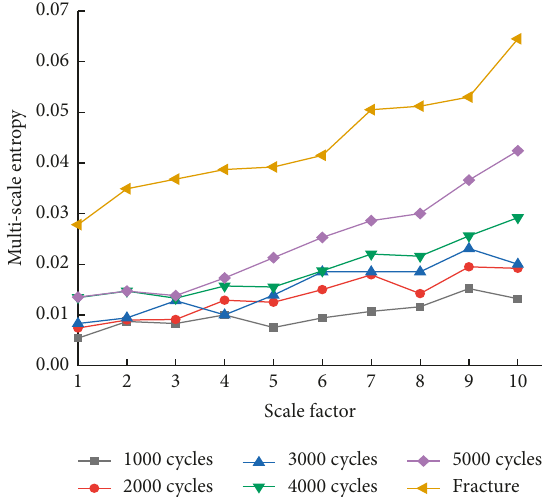
Figure 6: Multi-scale entropy of H